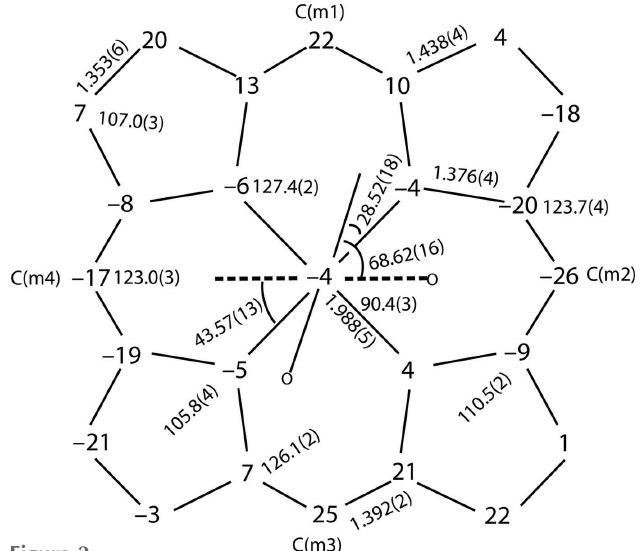
Figure 2 A formal diagram of the porphinato core of the title compound. Averaged values of the chemically unique bond length (A˚ ) and angles ( (cid:3) ) are shown. The numbers in parentheses are the standard uncertainties calculated on the assumption that the averaged values were all drawn from the same population. The perpendicular displacements (in units of 0.01 A˚ ) of the porphyrin core atoms from the 24-atom mean plane are also displayed. Negative values indicate a displacement toward the N7 1- ethylimidazole nitrogen atom. The solid line in this perspective indicates the 1-ethylimidazole ligand containing atom N7, and the dashed line indicates the 1-ethylimidazole ligand containing atom N5. The circle represents the position of the ethyl group on the axial ligand.